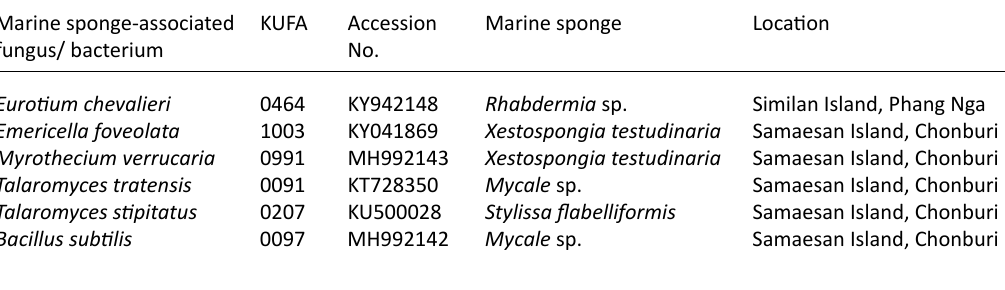
0207 KU500028 Bacillus subtilis 0097 MH992142 Mycale